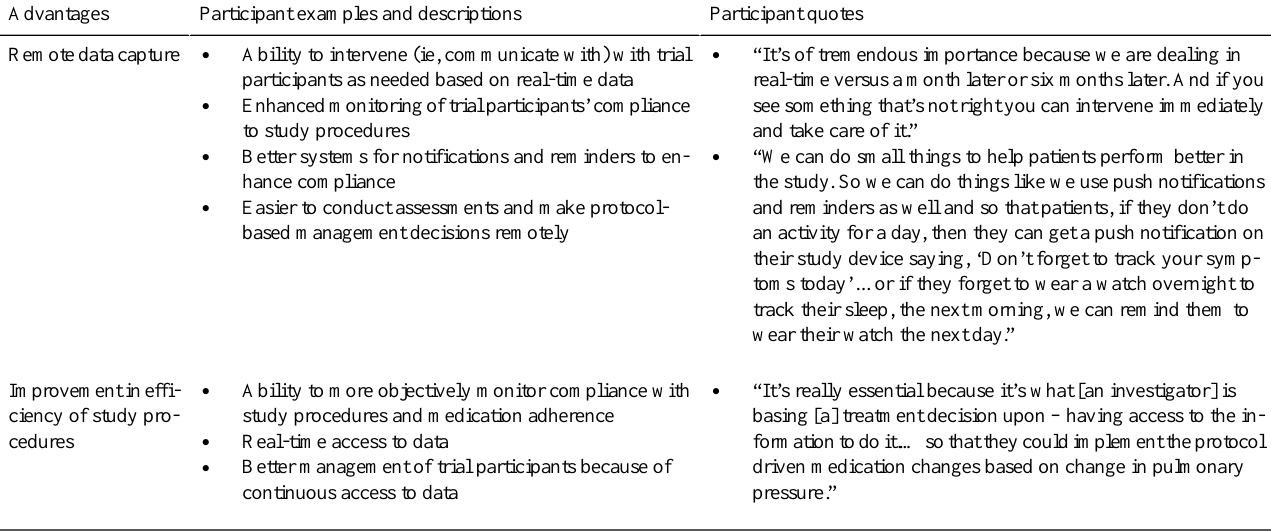
Table 4. Investigator-specific advantages of mobile clinical trials.